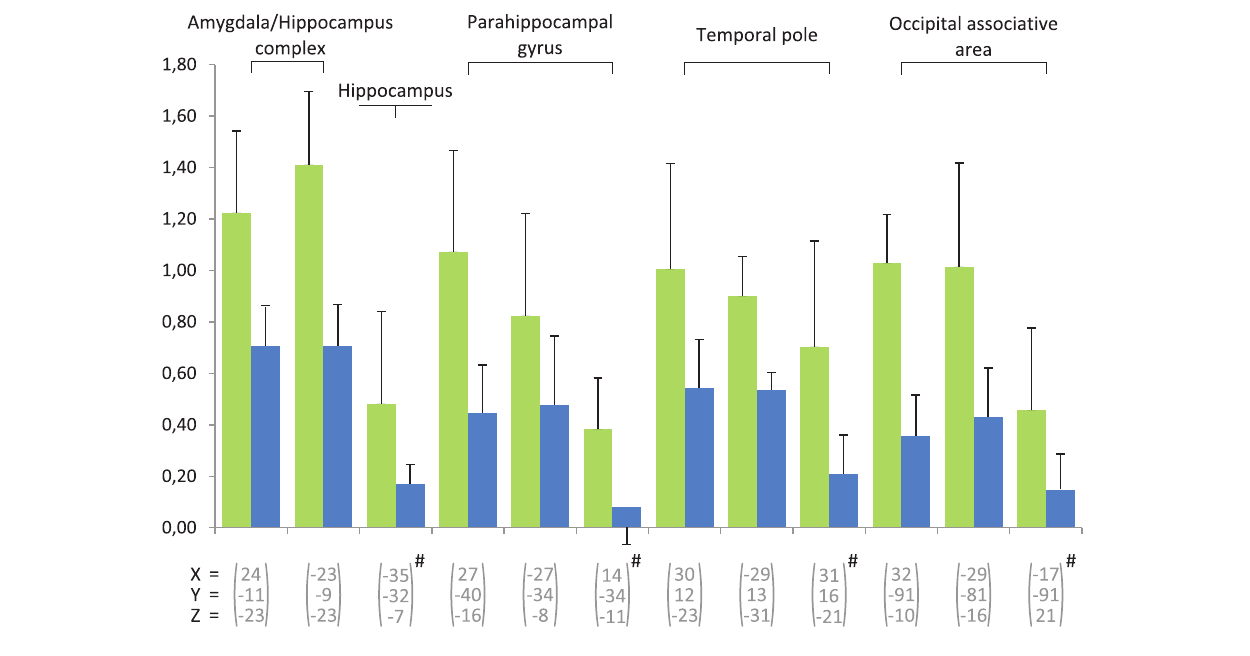
FIGURE 4 | Beta-values of the contrast experts minus controls calculated for the regions involved in memory. Two conditions are concerned, in green for the wine and in blue for water. The